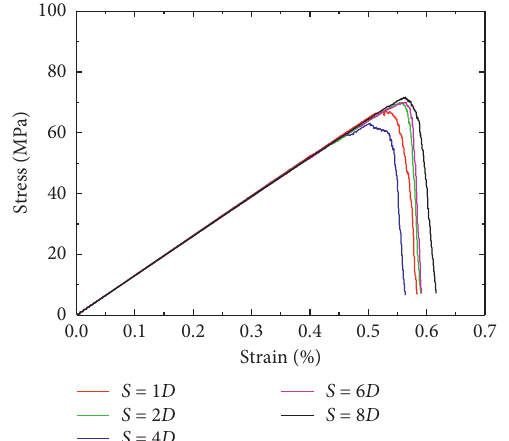
Figure 12: Stress-strain curves of rock samples with different boreholes dip angles.